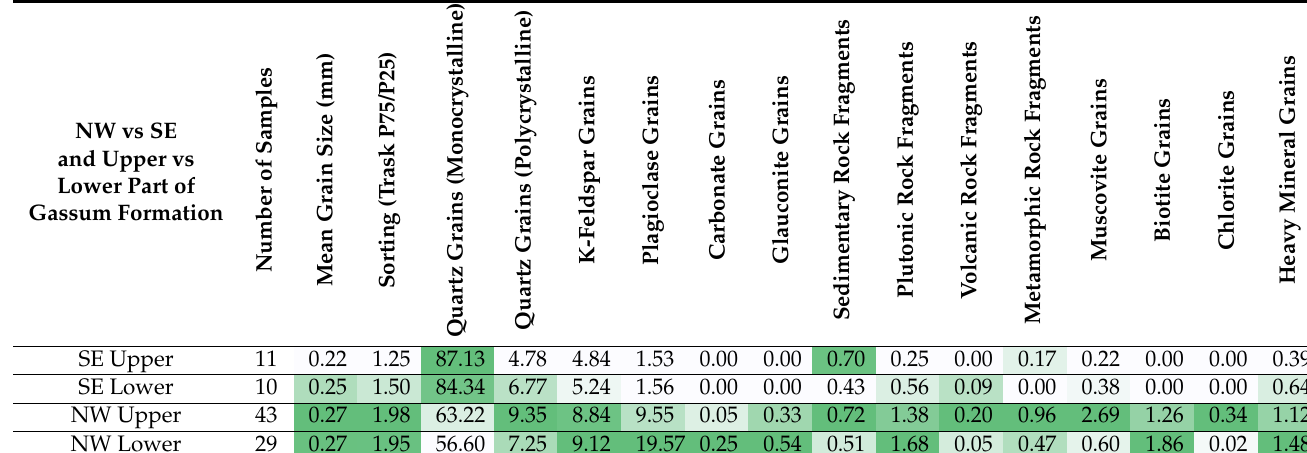
Table 1. Mineralogical composition of detrital grains in the Gassum Formation based on petrographic point counting. The southeastern part of the formation is better sorted and contains more quartz than the northwestern part of the formation, which has much higher contents of most other types of grains. Some clear differences are evident between the lower and upper intervals of the northwestern part of the formation. SB 5 marks the boundary between the lower and upper intervals of the Gassum Formation. Data from the southeastern part of the Gassum Formation are from the Margretheholm- 1, Stenlille-1, -5, -15, -18, and -19 wells, and data from the northeastern part are from the Aars-1, Børglum-1, Farsø-1, Fjerritslev-2, Flyvbjerg-1, Gassum-1, Thisted-3, and Vedsted-1 wells. Each column has been formatted with a separate color scale from highest (green) to lowest (white)